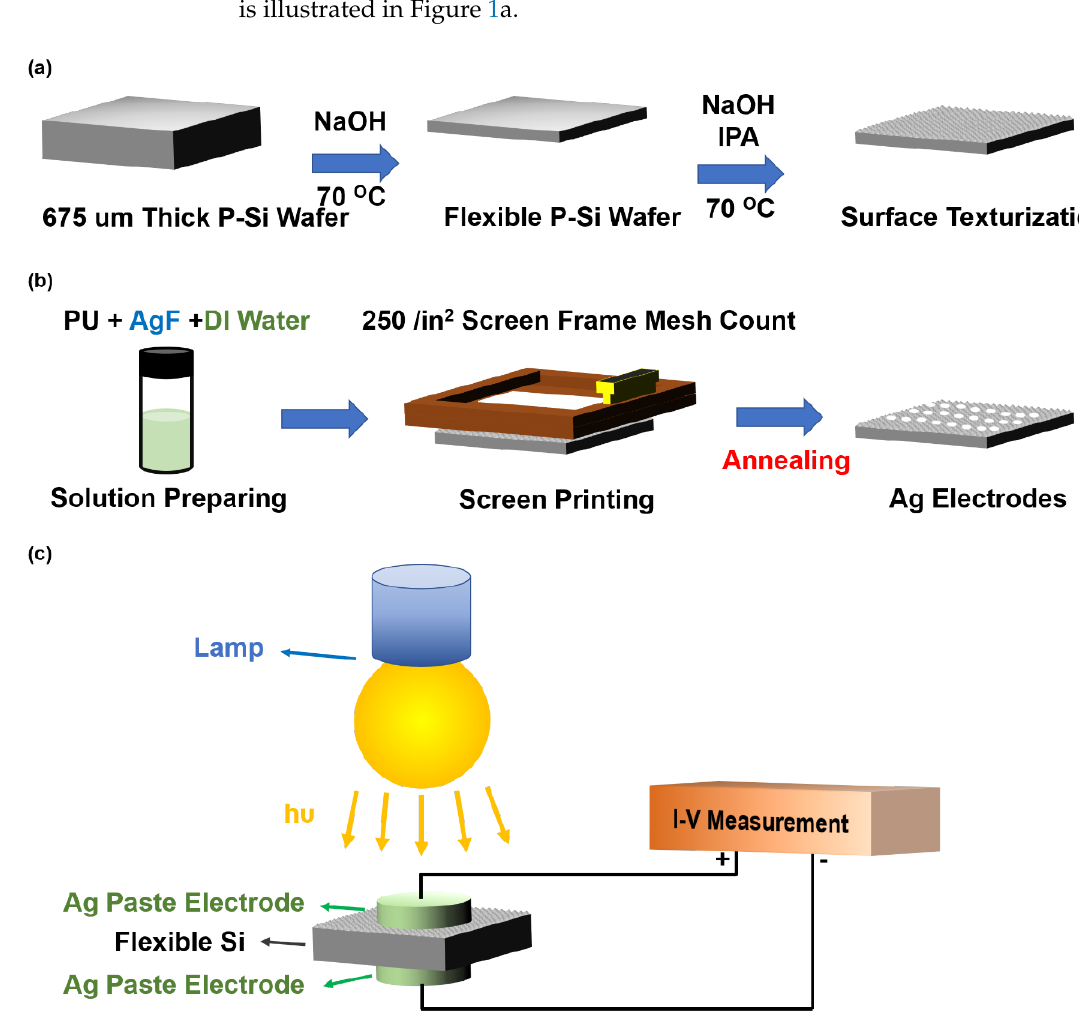
Figure 1. The fabrication process of ( a ) flexible Si with surface texturization and ( b ) Ag electrodes with the screen-printing method. ( c ) Schematic diagram of the photoelectric measurement system with the MSM structure. The electrical properties of the MSM structure were measured using the probe system, and the incident light power was controlled by the lamp.